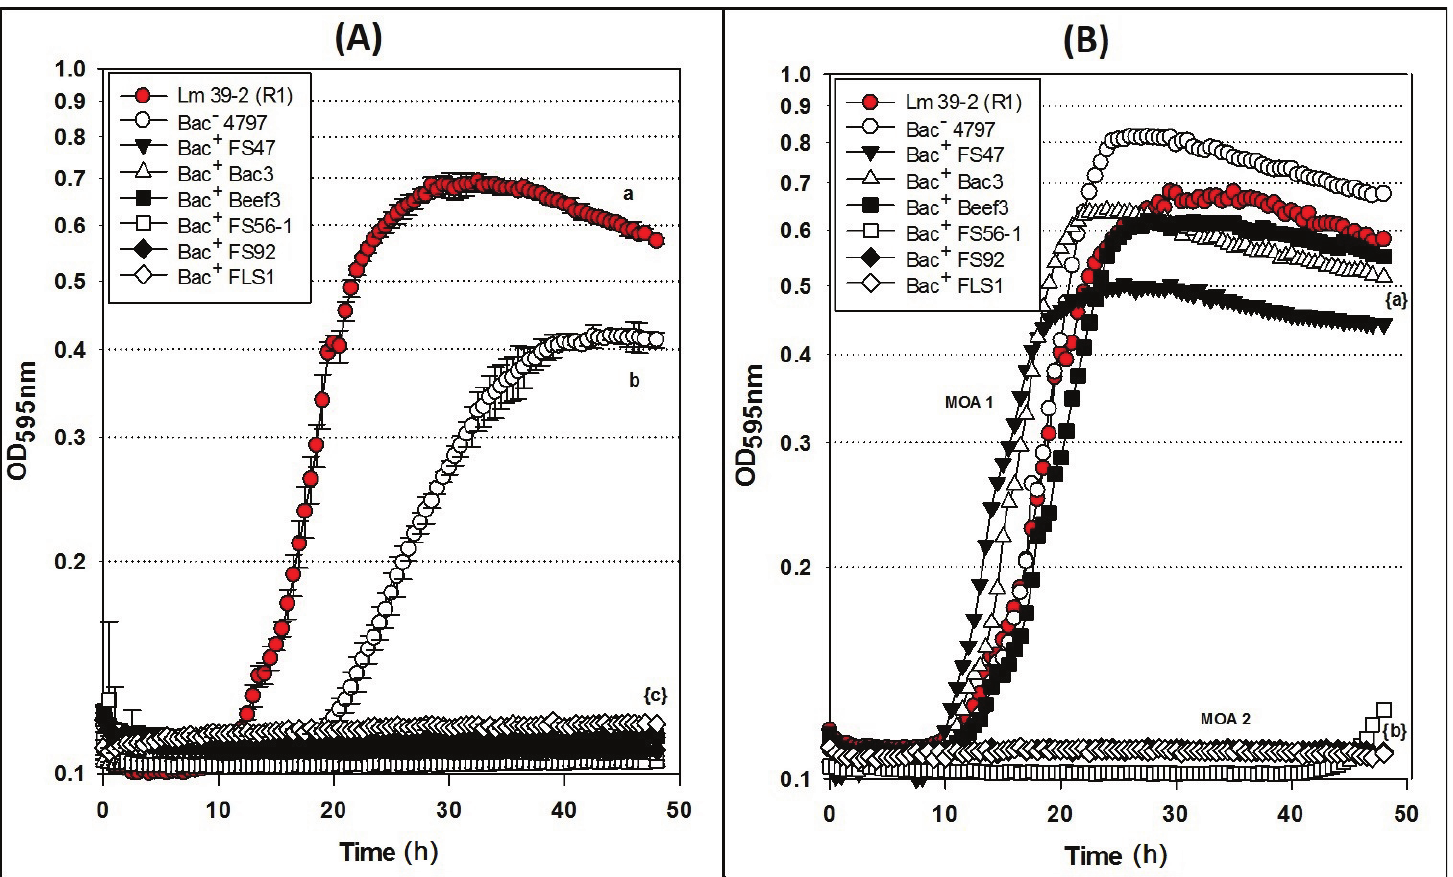
Figure 5. Microplate growth inhibition assays showing the activity of Listeria monocytogenes 39-2 (R1) treated with culture supernatants from: None (R1 Cont.), Lb. delbrueckii 4797-2 (Bac (cid:2) ), Lb. curvatus FS47, P. acidilactici Bac3, Lb. curvatus Beef3, En. faecium FS56-1, En. thailandicus FS92, and Lc. lactis FLS1. ( A ) Microplate assay using non-neutralized culture supernatants; ( B ) Microplate assay using neutralized culture supernatants. Data points represent the means of triplicate replications and error bars represent the standard deviations from the means (error bars were not used for all curves in order to prevent clutter). Treatments with different lowercase letters are significantly different ( p < 0.05); letters in brackets are for entire group of graph